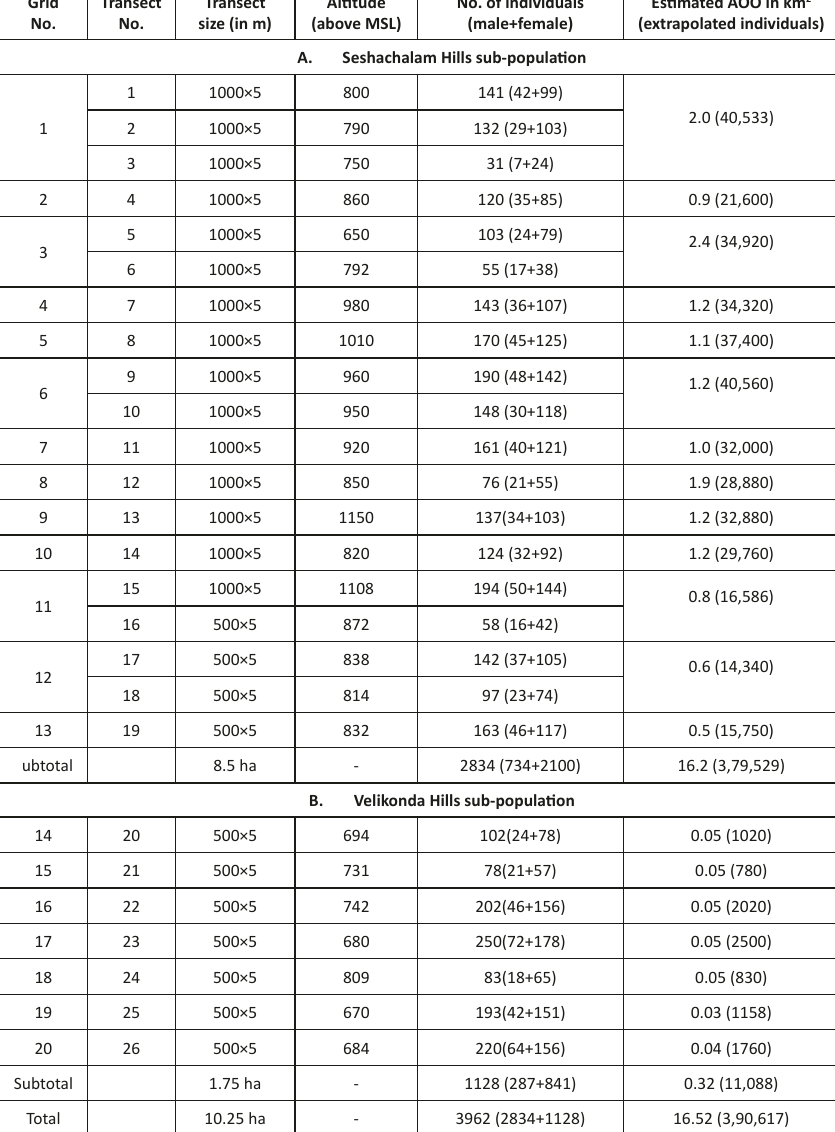
Table 1. Sampled inventory of Cycas beddomei